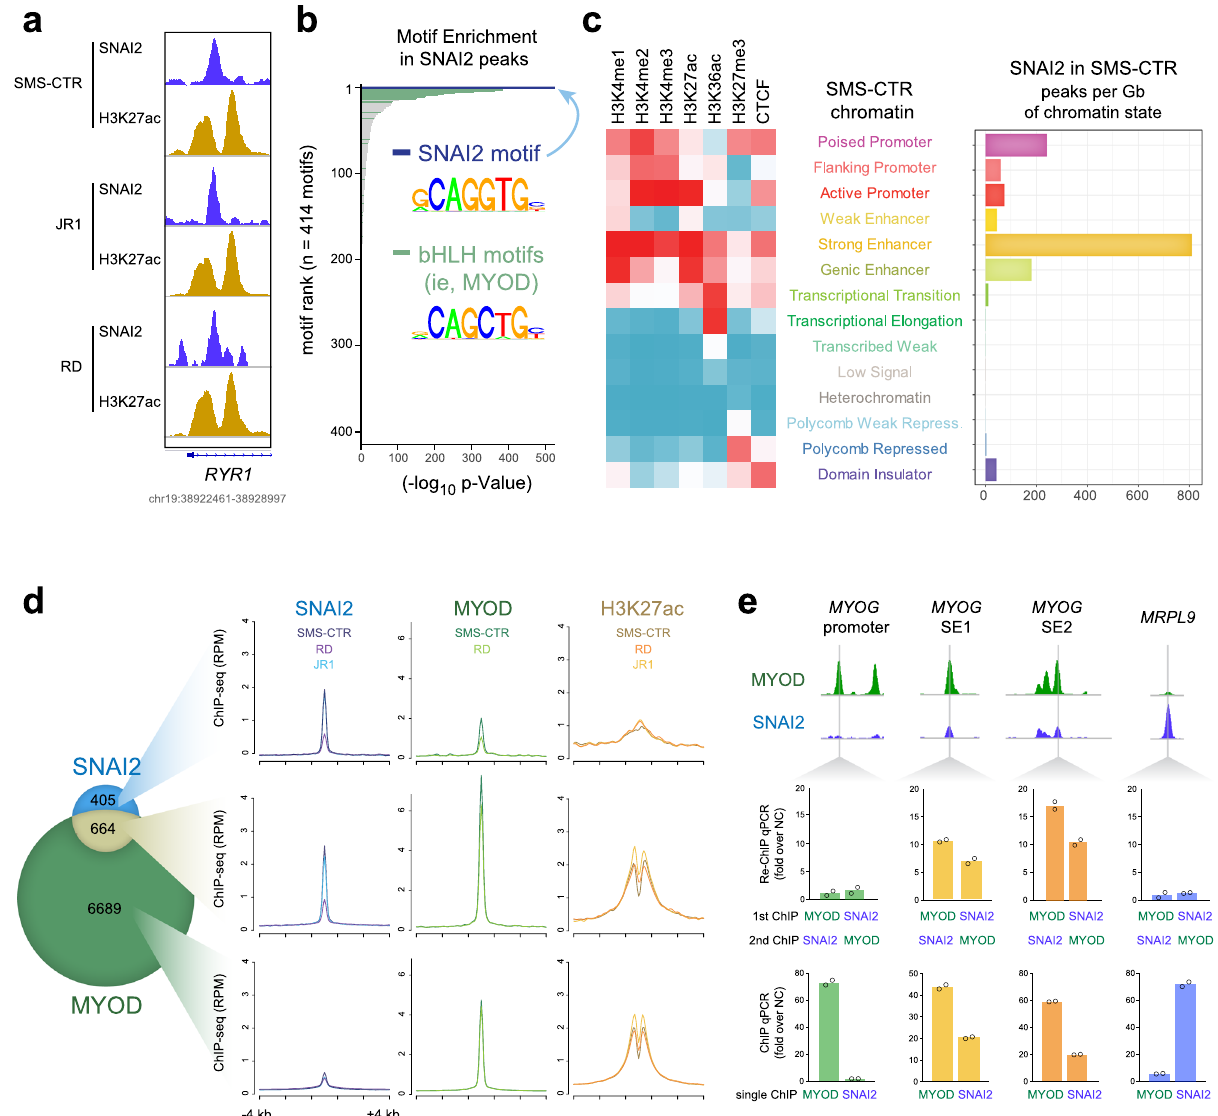
Fig. 4 SNAI2 binds key enhancers in FN-RMS. a ChIP-seq signal for SNAI2 and H3K27ac peaks shared in all three cell lines are shown. b Hypergeometric Optimization of Motif EnRichment (HOMER) analysis identi fi ed SNAI2 binding motifs (top) as well as bHLH (basic helix-loop-helix) motifs at SNAI2 shared peaks using the HOMER package (homer.salk.edu/homer/ngs/peakMotifs.html). p statistic is calculated using the HOMER statistical comparison against size matched DNA sequences from randomly selected background genomic sequences. c Chromatin states in SMS-CTR cells (left) and abundance of SNAI2 peaks per Gb of each state (right). d Venn diagram (left) and average plot for ChIP-seq signal (right) depicting overlap between SNAI2 (2 or all 3 cell lines) and MYOD (2 cell lines) binding sites. RPM, Reads Per Million Mapped Reads. e Co-occupancy of MYOD and SNAI2 as measured by ChIP- reChIP and qPCR at locations previously identi fi ed (by ChIP-seq) as being preferentially bound by MYOD, SNAI2, or both. Single-target ChIP-qPCR controls are shown below ( n = 2 biologically independent experiments, data presented as mean